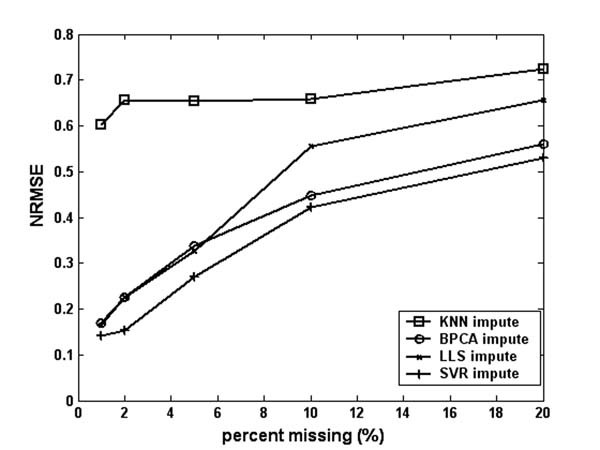
Performance of the four methods on data E.